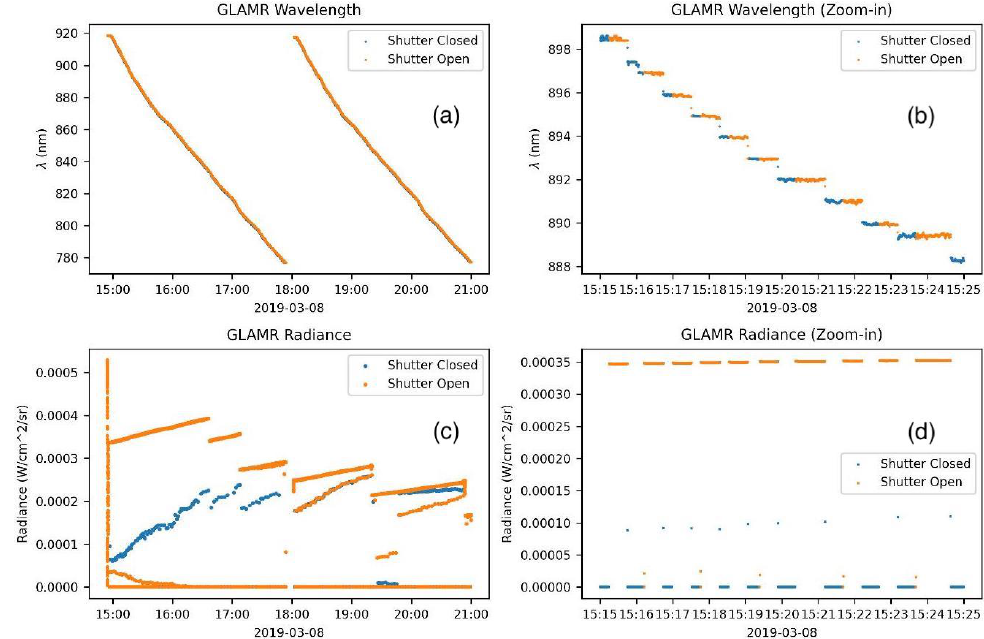
Figure 6. Outputs from the GLAMR monitors after pre-processing: ( a , b ) the wavelength; ( c , d ) the radiance. The input data are from 8 March 2019